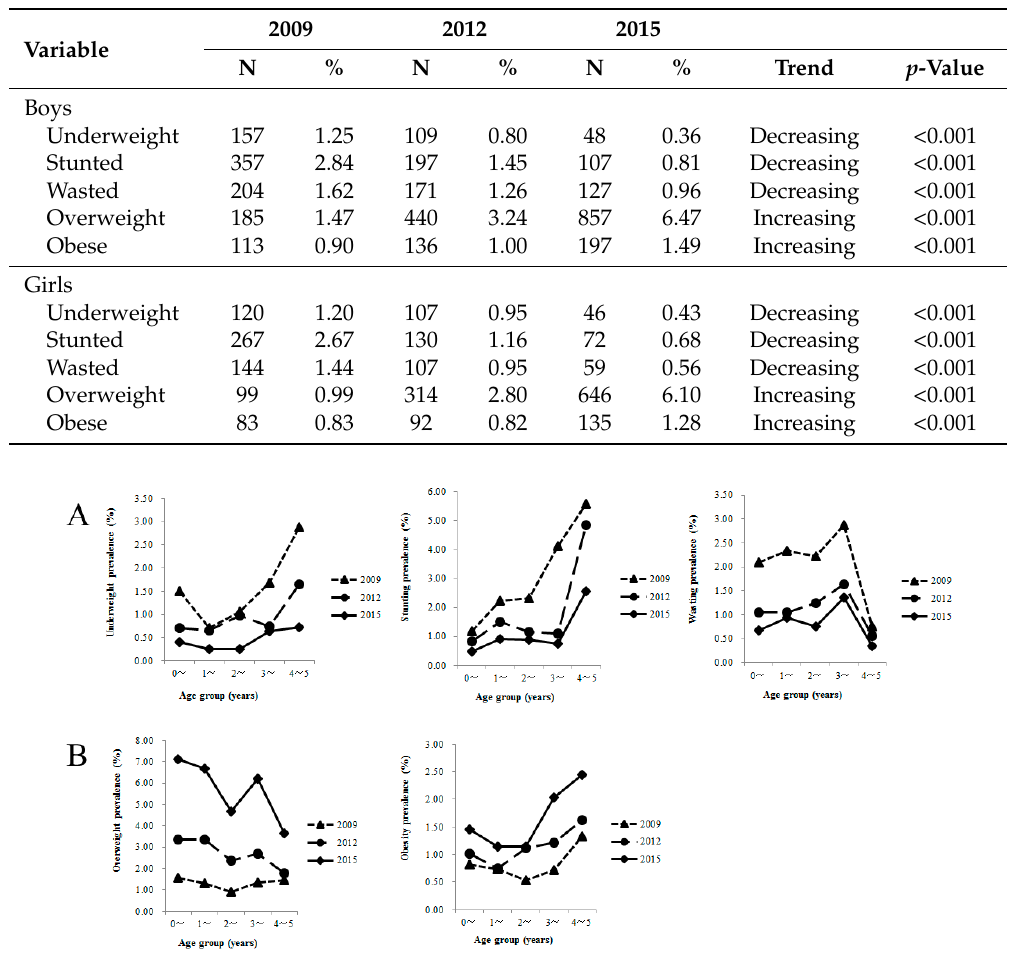
Table 4. Prevalence of nutritional indicators by sex and year of evaluation and differences in prevalence between years of evaluation by sex.